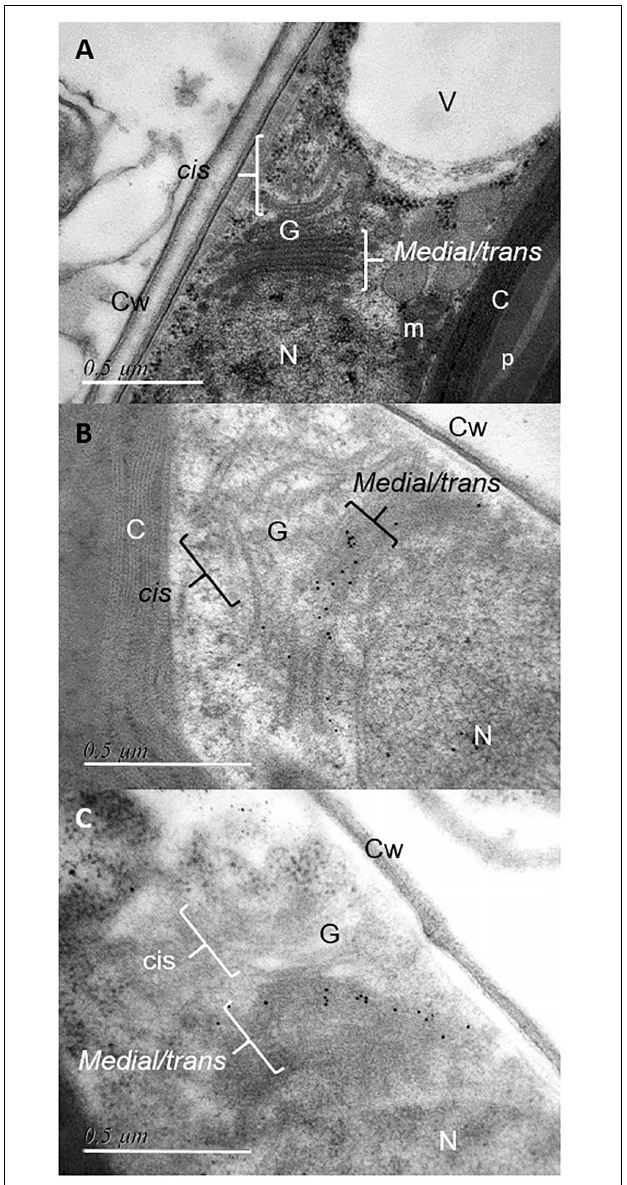
FIGURE 6 | Immunocytochemical localization of V5-tagged FuT54599 and V5-tagged GnT I in the Golgi apparatus of P. tricornutum. Transmission Electron micrographs of HPF/FS P. tricornutum cells which were embedded in LRW resin. (A) View showing a Golgi apparatus of P. tricornutum oriented as previously described for algae cells in Donohoe et al. (2007, 2013). (B) Localization of the V5-tagged GnT I in the medial-trans Golgi cisternae of P. tricornutum Golgi apparatus after immunolabelling with a mouse anti-V5 antibody used as a primary antibody (dilution 1/20) and a secondary antibody coupled to 10 nm gold beads (dilution 1/20) and then contrasted with uranyl acetate and lead citrate. (C) Localization of the V5-tagged FuT54599 in the median-trans Golgi cisternae of P. tricornutum Golgi apparatus after immunolabelling with a rabbit anti-V5 antibody used as a primary antibody (dilution 1/20) and a secondary antibody coupled to 10 nm gold beads (dilution 1/20) and then contrasted with uranyl acetate and lead citrate. N, nucleus; G, Golgi apparatus with cis and medial/ trans cisternae; V, vacuole; m, mitochondria; p, pyrenoid; C, chloroplast; Cw, cell wall. Scale bar: 0.5 µ m. Please refer to the Supplementary Figure S4 for negative controls.